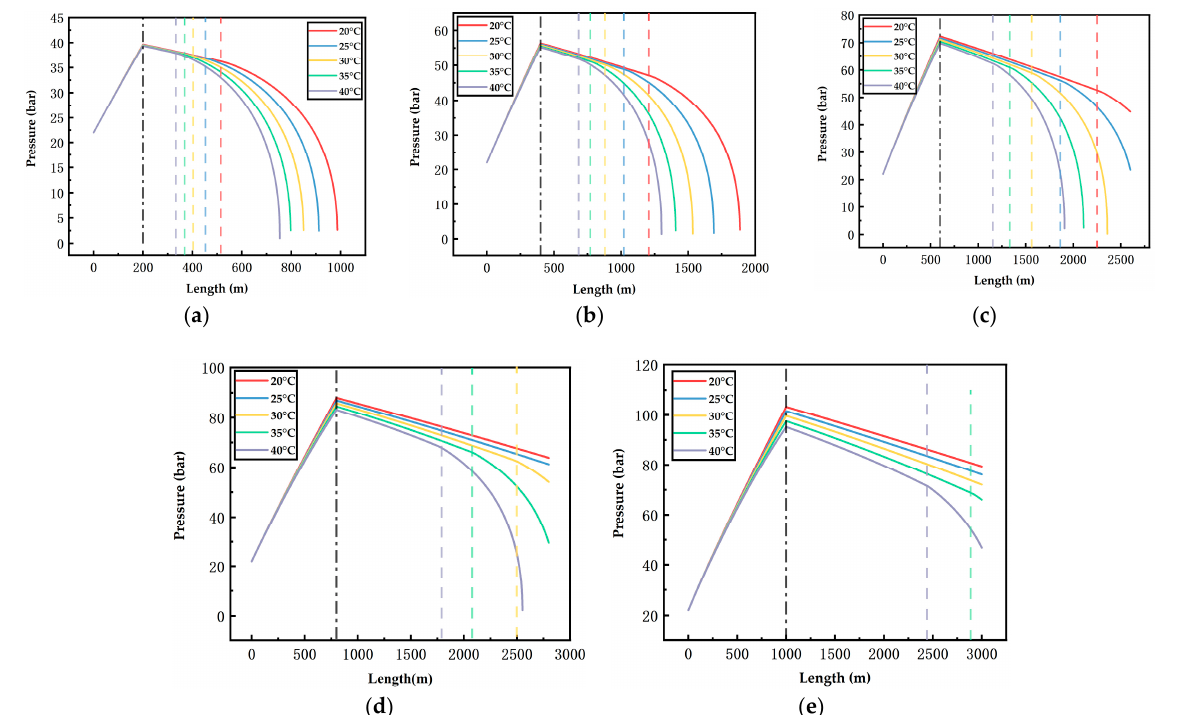
Figure 9. Variation of the on-way pressure with the length at 1 m/s airflow velocity, different ambi- ent temperatures and depths (( a ) 200 m; ( b ) 400 m; ( c ) 600 m; ( d ) 800 m; ( e ) 1000 m). The black dotted line indicates the connection between the vertical pipe and the underground pipe; The dotted lines in other colors represent gasification points.